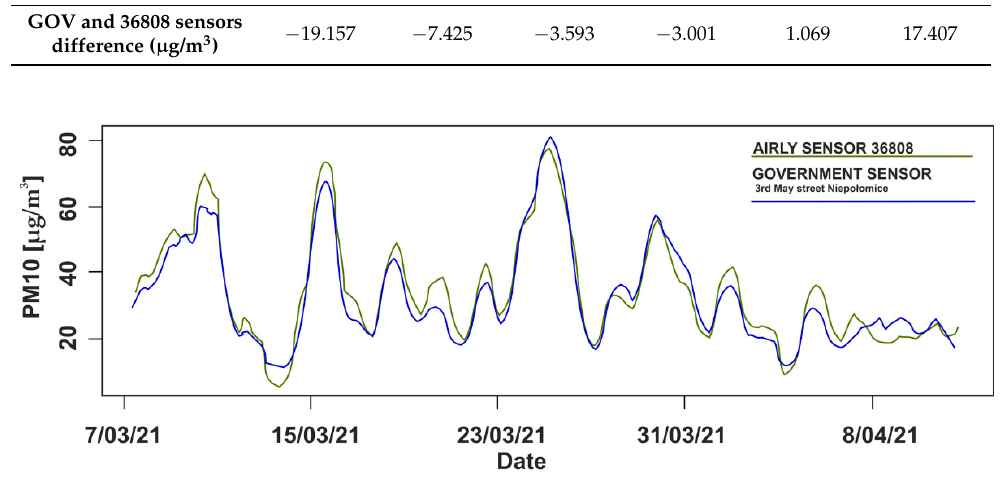
Figure 3. Twenty-four-hour averaged measurements of PM10 from government stations (blue) and Figure 3. Twenty ‐ four ‐ hour averaged measurements of PM10 from government stations (blue) and the Airly sensor (green) in the Airly sensor (green) in Niepo ł omice.